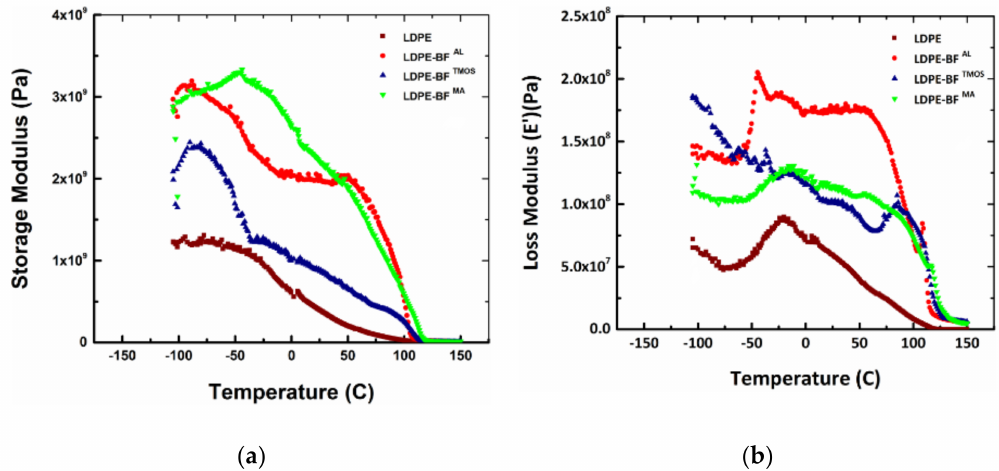
Figure 11. ( a ) Storage modulus and ( b ) loss modulus of LDPE, LDPE-BFs AL , LDPE-BFs TMOS and LDPE-BFs MA